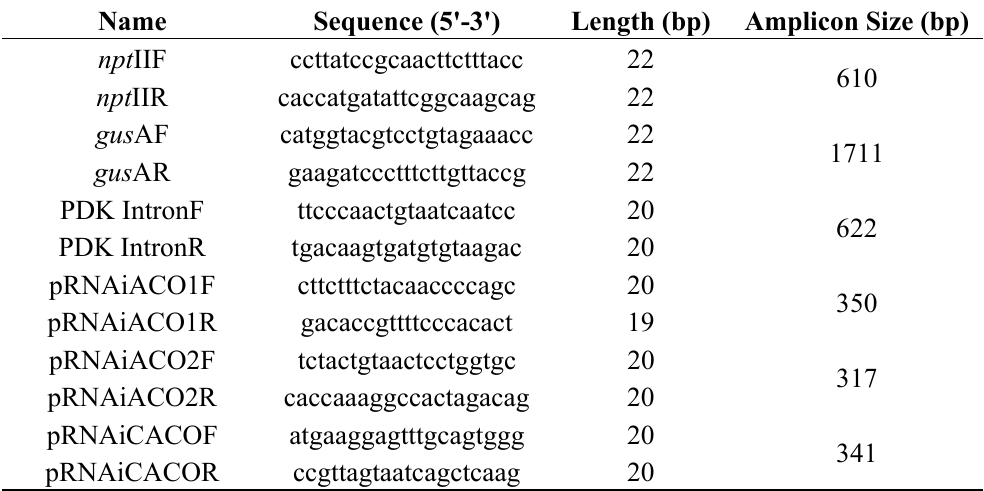
Table 3. List of primers used for analysis of RNAi transgenic papaya